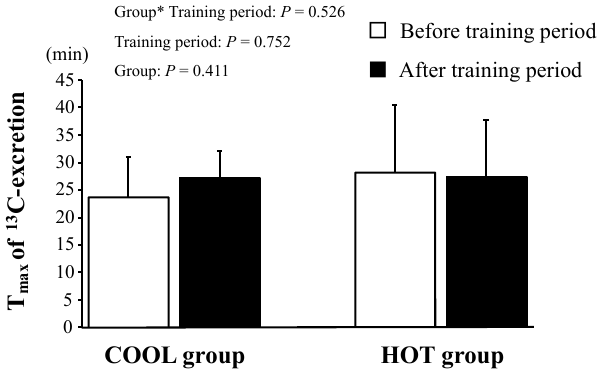
Figure 3. 13 C-excretion after HST before and after the training period in both COOL ( a ) and HOT groups ( b ). Values are means ± SD. *: Significant main effect of training.